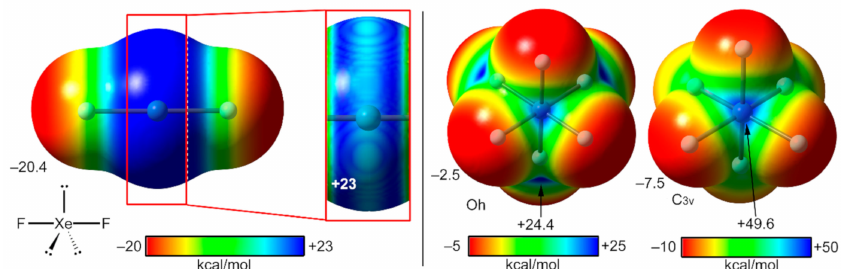
Figure 15. Left : MEP surface of XeF 2 showing the location of the positive belts. Isosurface 0.01 a.u. Right : MEP surfaces of the octahedral and C 3v forms of XeF 6